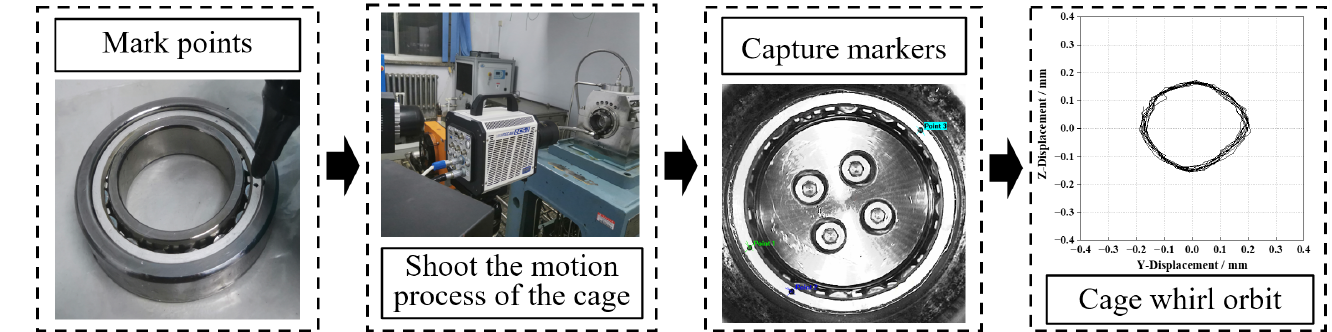
Figure 4. Main part of testing machine.